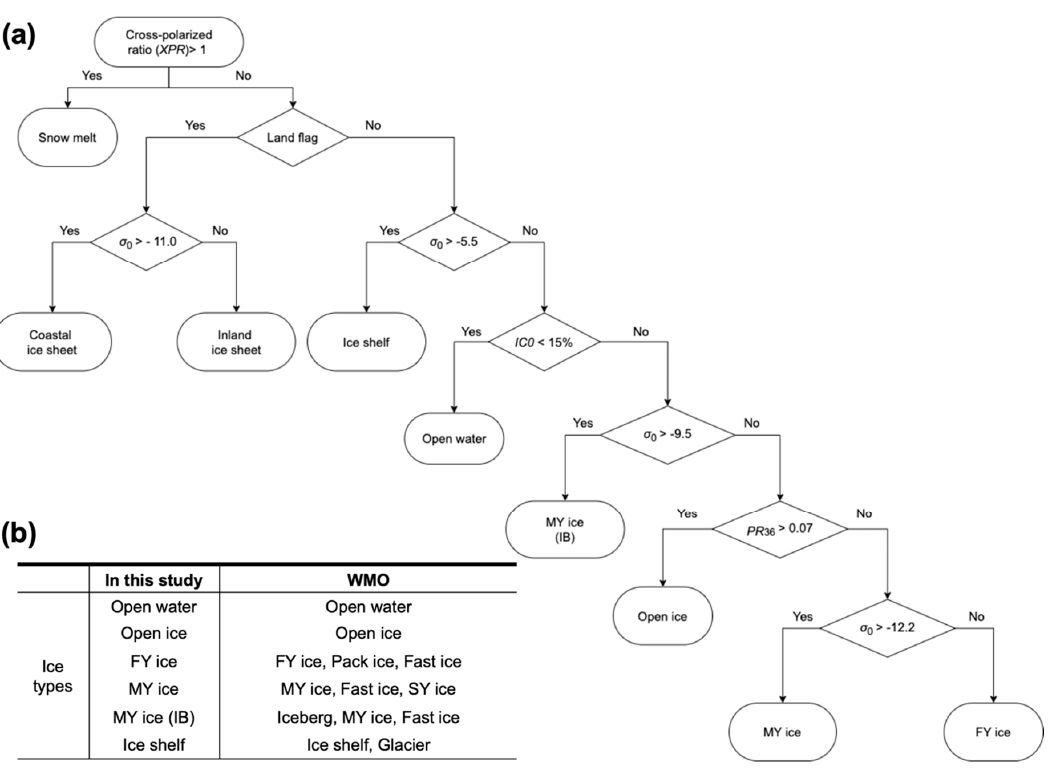
Figure 4. ( a ) Workflow for the ice classification algorithm based on the σ 0 values, brightness temperature ( T B ), and sea ice concentration ( SIC ) data. ( b ) Table summarizing the different ice types defined in this study and the WMO’s defined ice types. FY: First-year; MY: Multi-year; IB: Iceberg; SY: Second-year. XPR: Cross-polarization ratio.